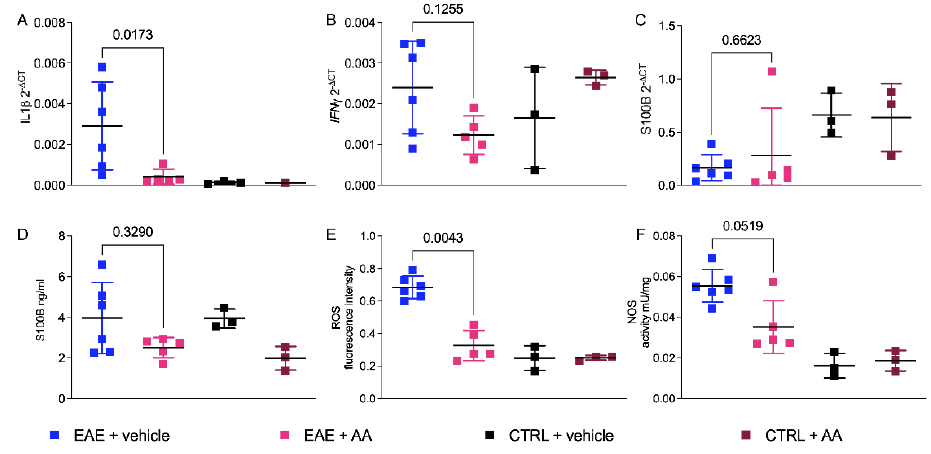
Figure 3. Effects of AA on inflammatory cytokines, S100B, and oxidative stress enzymes. ( A – C ) Comparison of gene expression levels (2 − ∆ CT ) of inflammatory cytokines and S100B among different groups of mice: treated (AA; fuchsia squares) and untreated (vehicle; blue squares) EAE, and treated (AA; magenta squares) and untreated (vehicle; black squares) controls. From ( A ), it can be seen that the reduction of IL1 β in EAE-affected mice treated with AA was statistically significant ( p = 0.0173, t -test, Mann − Whitney U test). IFN γ ( B ) and S100B ( C ) expression levels which did not present differences between the AA- and vehicle-treated EAE groups. ( D ) S100B protein levels (nanograms/milliliters) resulting in a trend of reduction in the AA-treated EAE group, although not statistically significant. ROS (( E ); p -value = 0.0043, t -test, Mann − Whitney U test) and NOS (( F ); p -value = 0,0519, t -test, Mann − Whitney U test) activities displayed as fluorescence intensity and as milliunits/milligrams, respectively. In ( E , F ), oxidative stress enzymes appeared to be significantly reduced by AA treatment during EAE. The statistical analyses comparing the EAE-affected and control groups are not